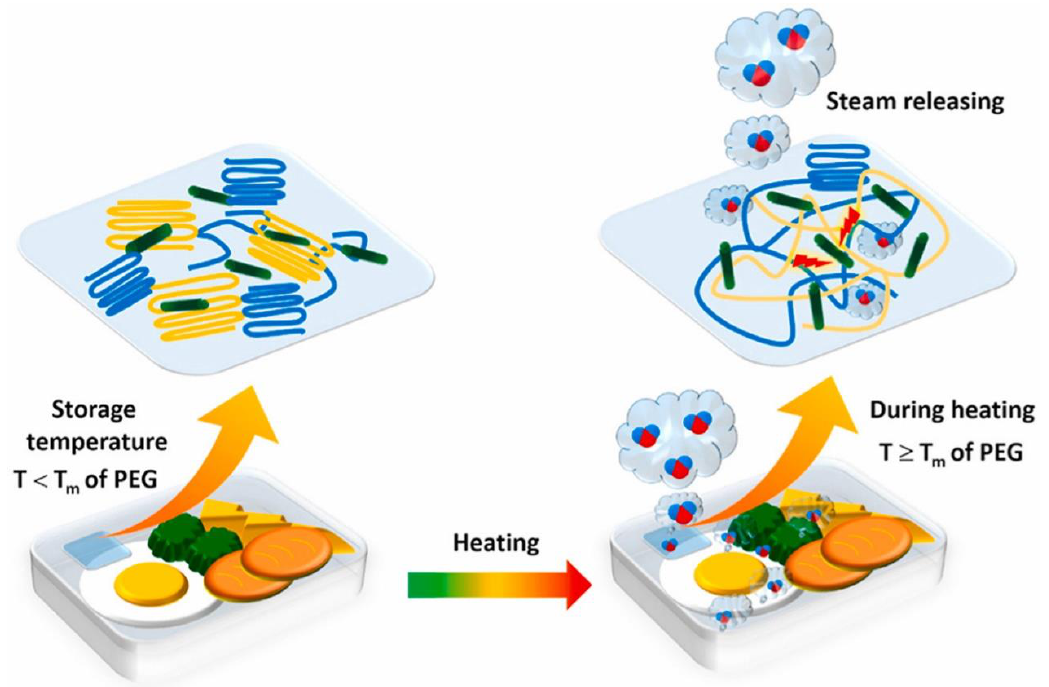
Figure 7. Nanocomposite films based on Pebax and HNTs as self-venting packaging materials (from ref. [64]).